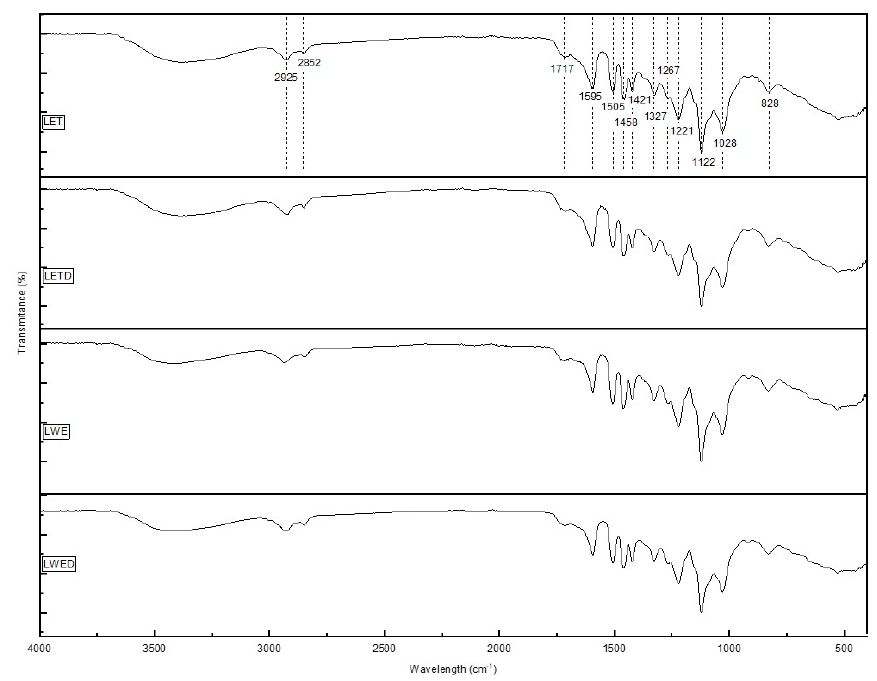
Figure 1. FTIR absorption spectra for isolated lignins LET, LETD, LWE, and LWED. Lignins have characteristic signals in the region between 700 and 1600 cm − 1 , and typ- ical chemical group stretching was observed between 2800 and 3500 cm − 1 . Characteristic bands of the lignin structure present at 1593, 1505, and 1422 cm − 1 were assigned to the aromatic skeletal vibration. The presence of the three basic units of lignin was also evi- denced, where the syringyl (S) ring absorption is observed at 1327 cm − 1 , the guaiacyl (G) ring appears with a small shoulder at 1267 cm − 1 , and for p -hydroxyphenyl (H) units, an absorption band is observed at 833 cm − 1 . The presence of both absorption bands at 1267 and 833 cm − 1 and a dominating peak at 1121 cm − 1 are typical of S:G:H lignins [42–44].